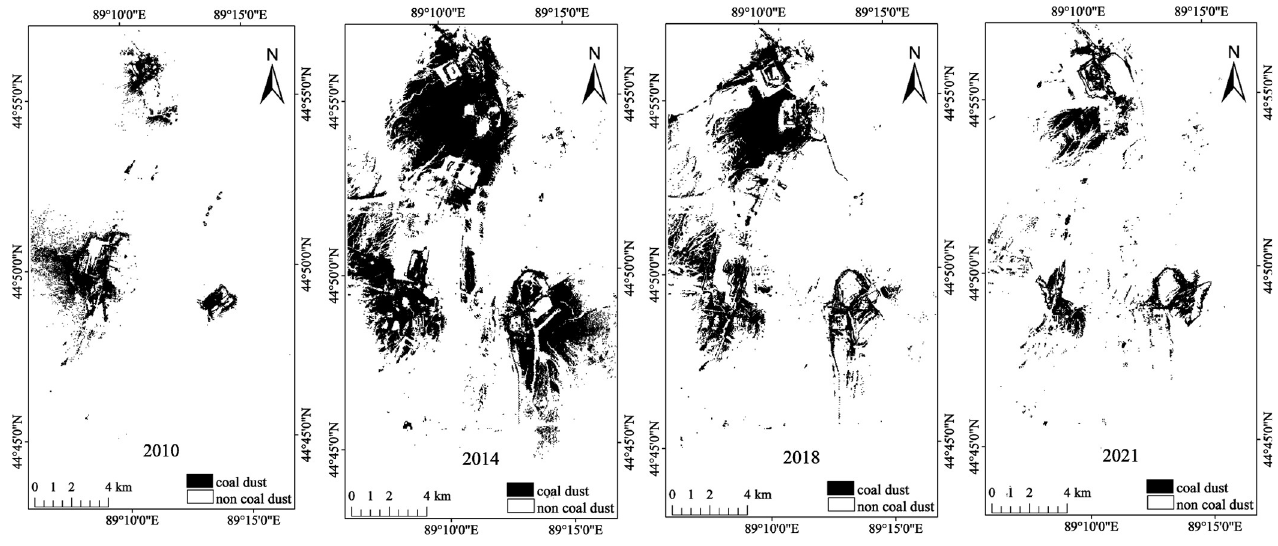
Fig 7. Binary images of the ECDI in 2010, 2014, 2018, and 2021.